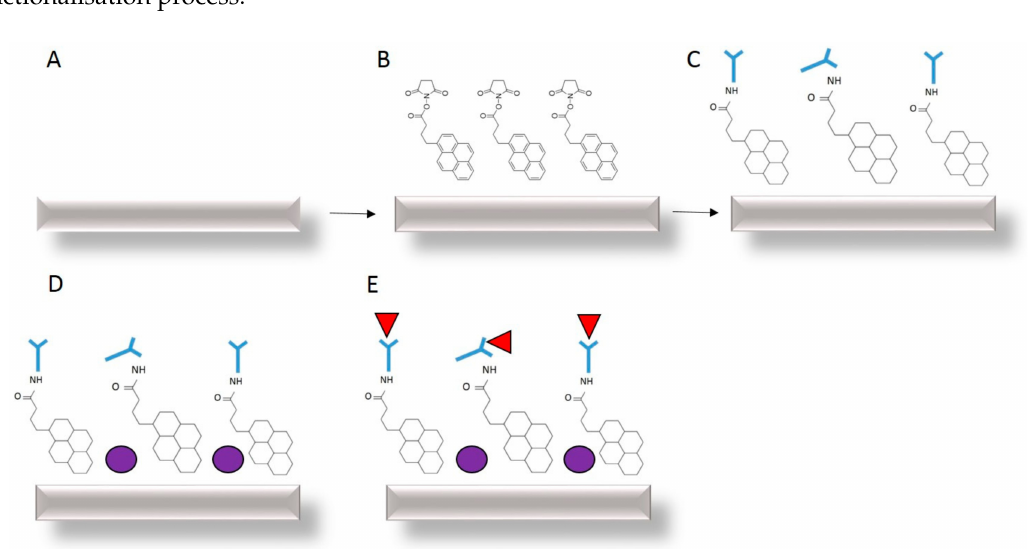
Figure 5. GFET functionalisation and measurement of ( A ) bare graphene ( B ) non-covalent attachment of Pyr-NHS ester linkers with graphene ( C ) anti-human chorionic gonadotropin (hCG) antibody (light blue) attachment to the linkers ( D ) BSA blocking (dark blue) and ( E ) detection of hCG antigen (red) binding with the antibody. Each stage is characterised using 4-probe electrical measurements of I D –V D and I D –V G